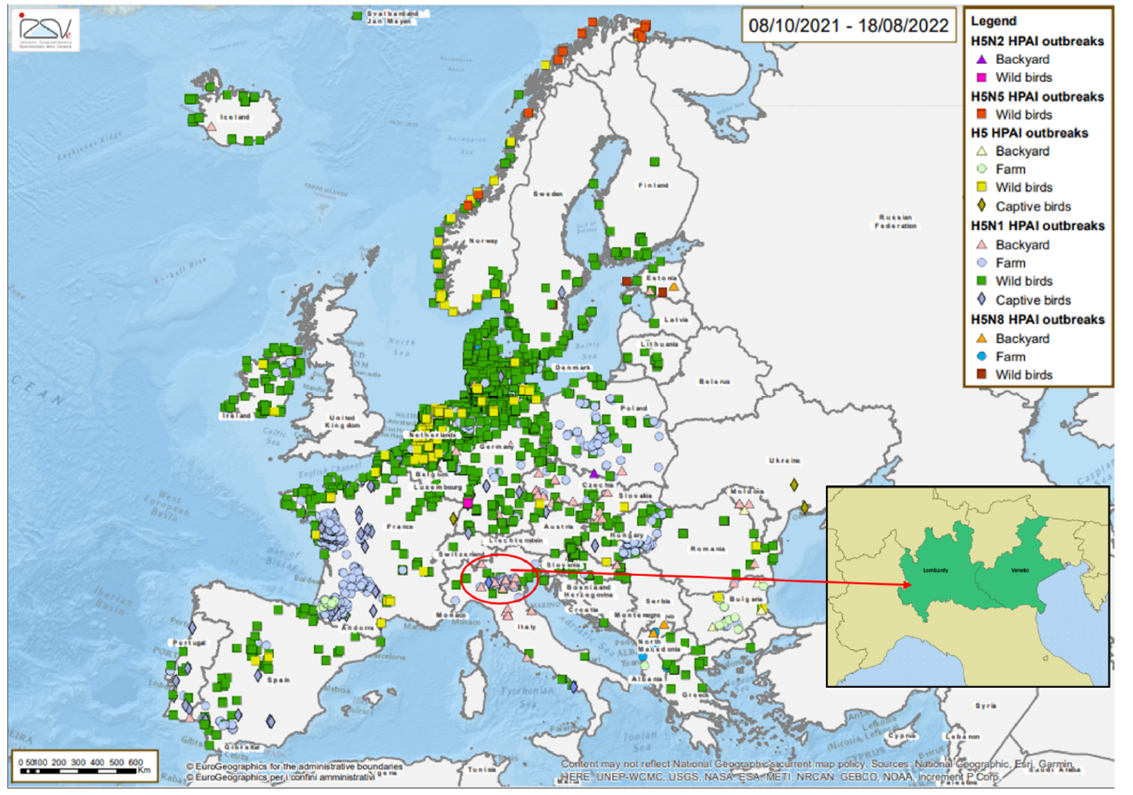
Figure 1. Map of the outbreaks detected during the HPAI 2021–2022 epidemic in Europe (source: Figure https://www.izsvenezie.it/documenti/temi/influenza-aviaria/situazione-epidemiologica-europa- HPAI/2021-1/mappe.pdf, accessed on 24 August 2022). In the red circle the affected regions of northern Italy (Veneto and Lombardy).